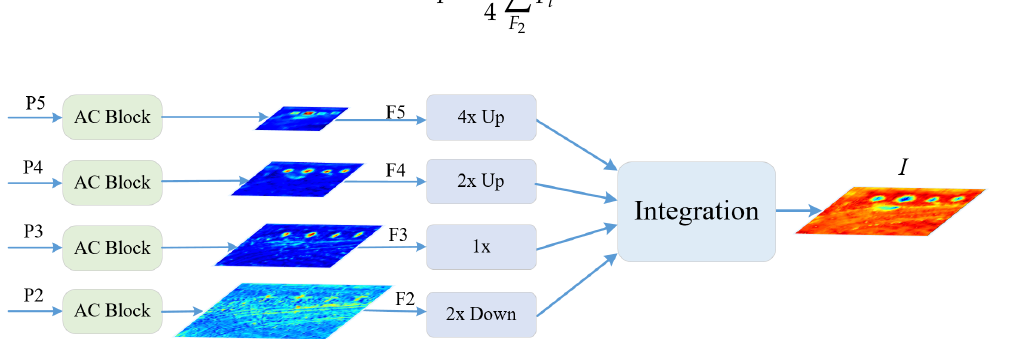
Figure 5. The structure of MFIN. Based on FPN, the AC Block is adopted to replace 3 × 3 convolution layer. To make the integration of multi-scale features, different resized operations are employed. Note that Up represents upsample layer and Down represents downsample layer, which are implemented by bilinear interpolation